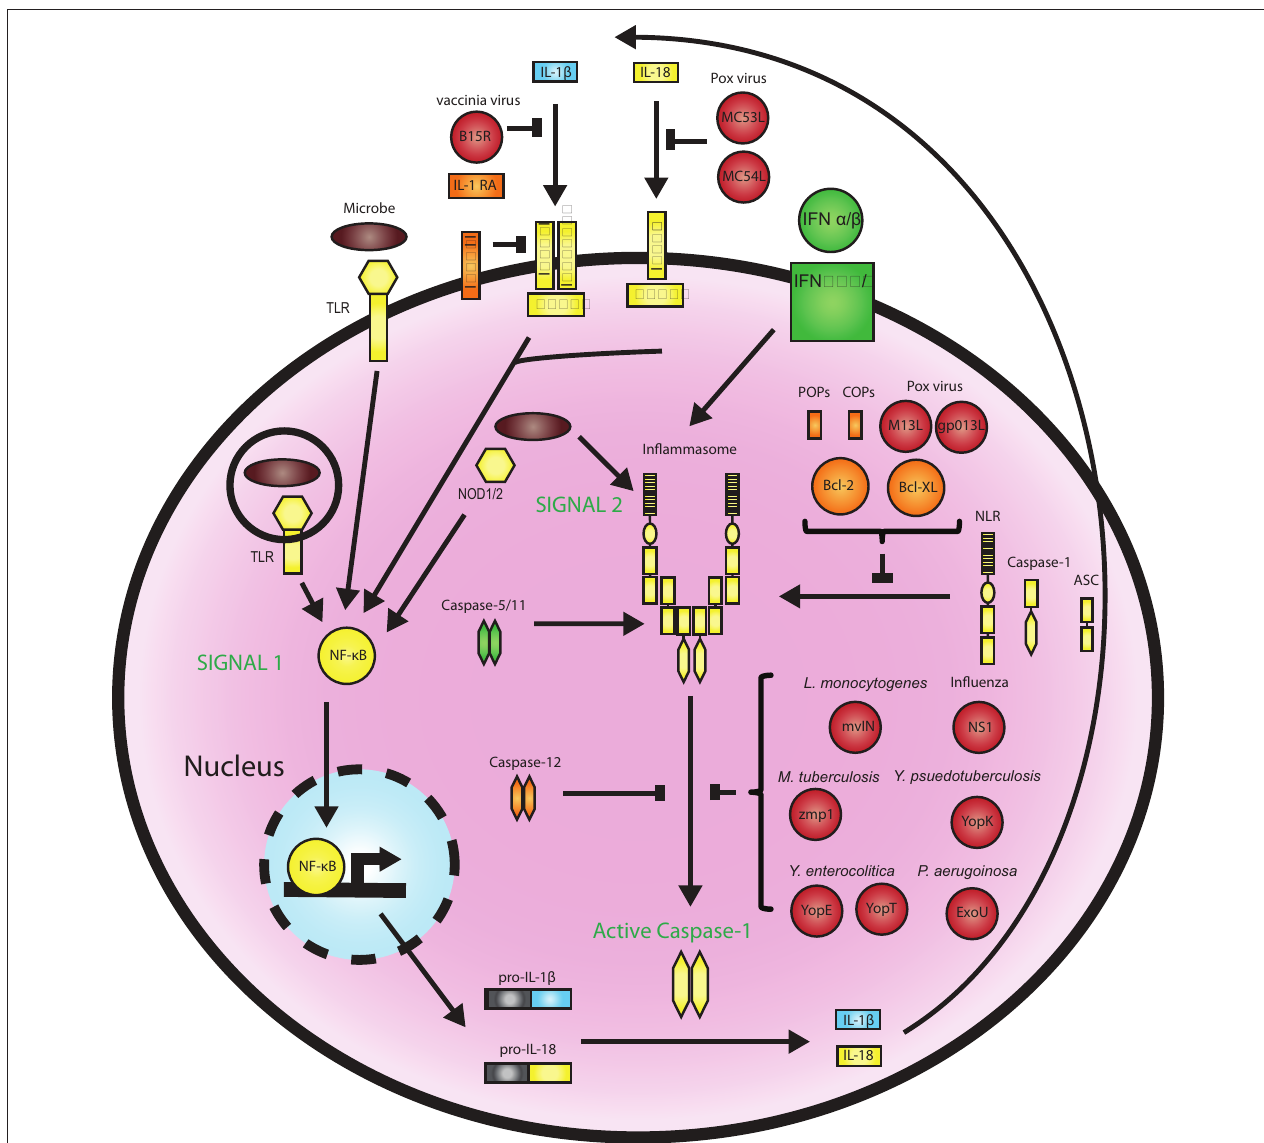
inflammasome assembly. Caspase-1 activation is inhibited by caspase-12, and multiple pathogen effectors, while murine caspase-11 and human caspase-5 are required for caspase-1 activation in response to certain stimuli. Type I IFN is required for AIM2 inflammasome activation in response to cytosolic DNA. inhibit L